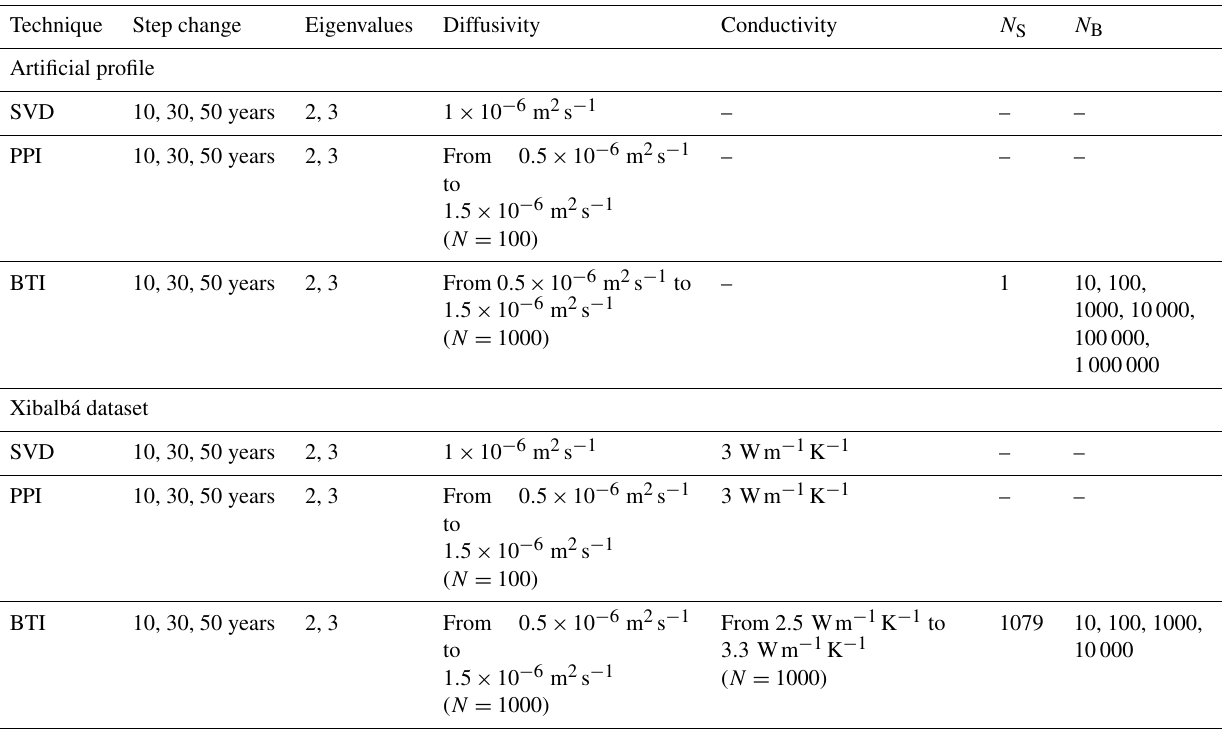
Table 1. Summary of the values for inversion parameters used to invert the artificial profile and logs from Xibalbá dataset. Columns contain the technique employed, the length of the time step used to retrieve the surface histories, the number of eigenvalues retrieved in the inversions, the values of thermal diffusivity considered, the values of thermal conductivity used to derive ground heat flux histories, the size of the Sampling ensemble of the BTI approach (in this case, the number of profiles considered, N S ), and the size of the Bootstrapping ensemble of the BTI approach ( N B ). All combination of parameters are explored in each